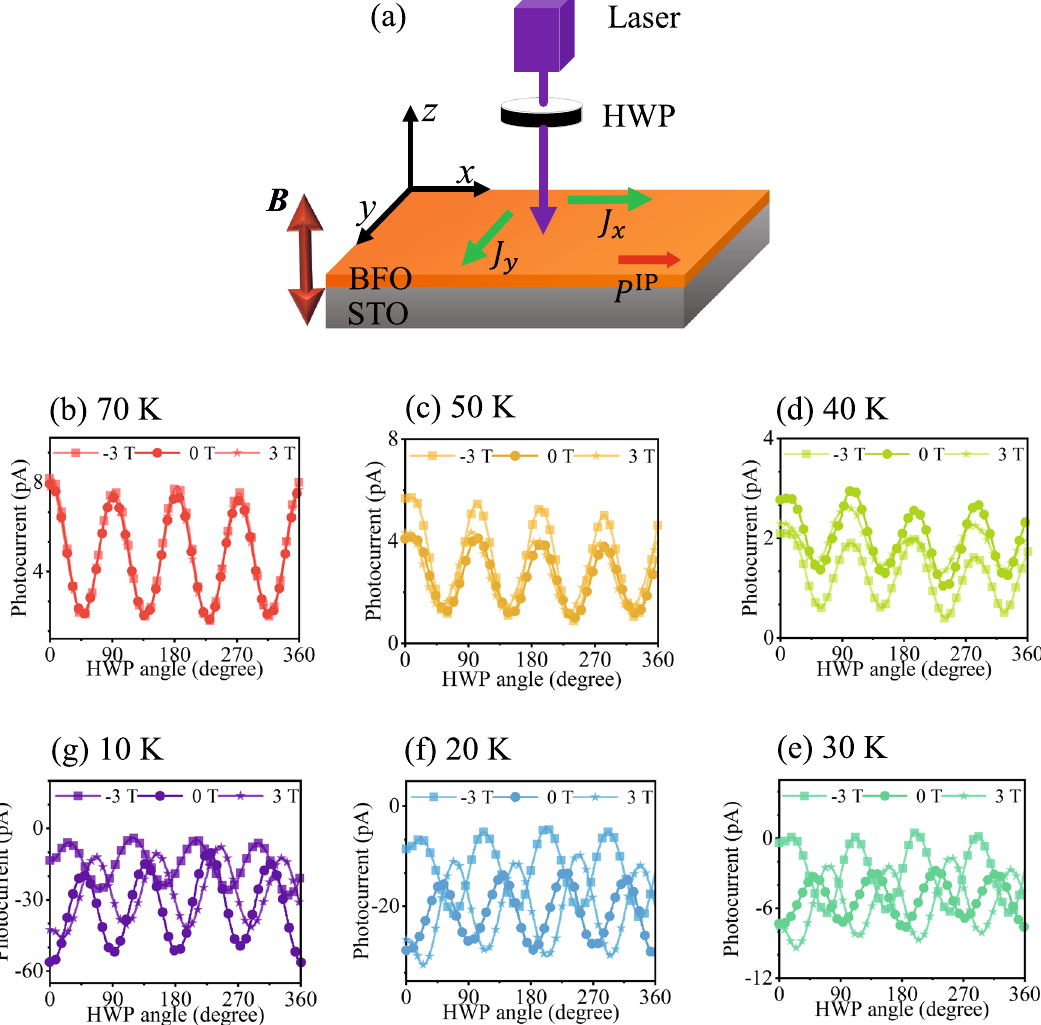
Fig. 1 Experimental setup and bulk photovoltaic (BPV) currents at different temperatures under a magnetic fi eld. a Schematic of the experimental setup for the measurement of the BPV effect in BiFeO 3 /SrTiO 3 (BFO/STO) under a magnetic fi eld B (deep red arrow) normal to the fi lm plane. The Photocurrents, indicated by the green arrow, are collected along either x direction ( J x ) or y direction ( J y ); the in-plane ferroelectric polarisation of BFO ( P IP ) is parallel to the x direction as indicated by the red arrow. A half-wave plate (HWP) was used to modulate the light polarisation. b – g HWP angle-resolved photocurrent J y at different temperatures under magnetic fi elds of − 3 T, 0 T, and 3 T. Detailed descriptions are given in the ‘ Photocurrent measurement